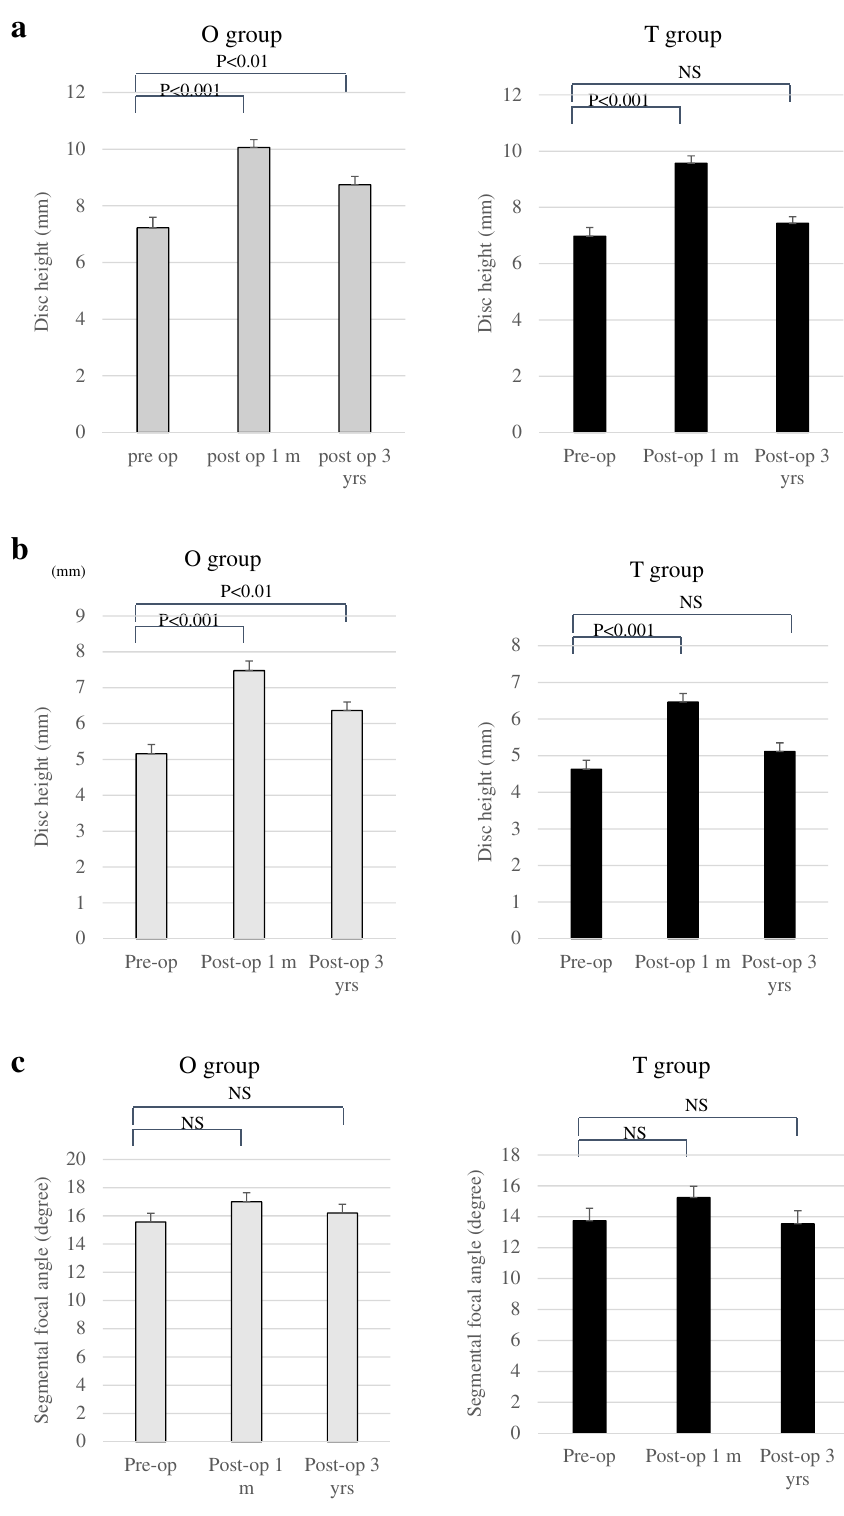
Figure 2. ( a ) Average change of anterior disc height. The anterior intervertebral height in the O group was significantly higher than that preoperatively. The anterior intervertebral height of the T group was significantly higher at one month compared with the preoperative level, but not at 3 years. ( b ) Average change of posterior disc height. The posterior intervertebral height shows the same trend as the anterior one. ( c ) Improvement rate of segmental focal angle. There was no significant difference in focal angle between the two groups at any time point. Abbreviations: T group, patients who underwent single-level transforaminal lumbar interbody fusion; O group, patients who underwent single-level oblique lateral interbody